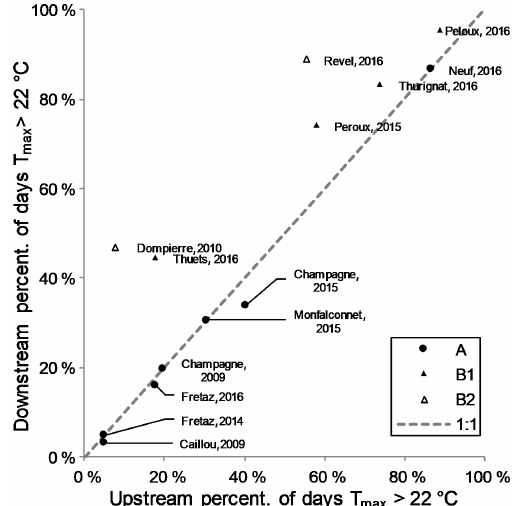
Figure 9. Percentage of the number of summer days with a diur- nal maximum water temperature above 22 ◦ C, upstream and down- stream of each site monitored in the study. A (circles), B1 (filled triangles), and B2 (open triangles) are the groups of sites resulting from the hierarchical cluster